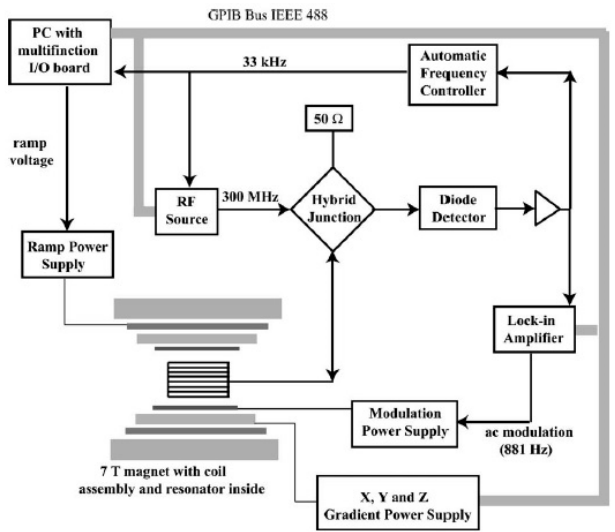
Figure 20. Block diagram of a setup for 3 dimensional continuous wave NMR imaging. (reproduced with permission from [62]. Copyright Elsevier, 2005).